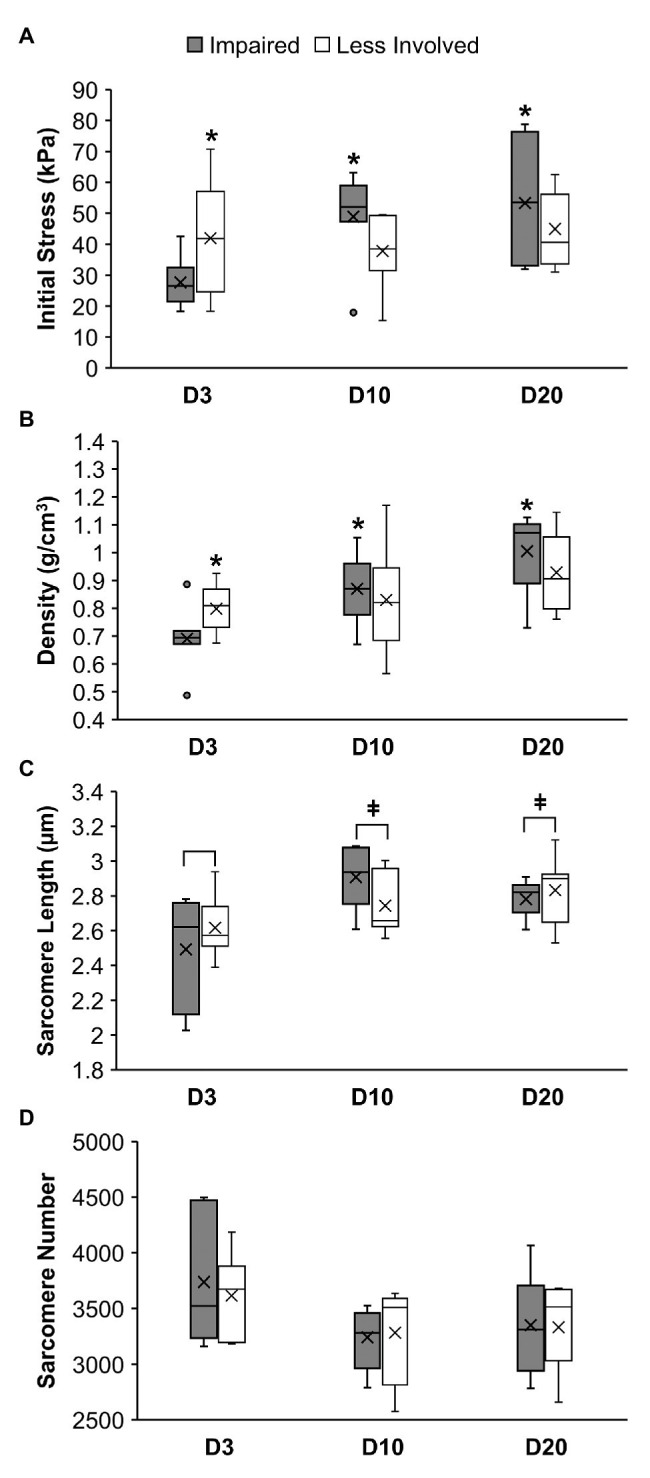
Muscle stress (A), muscle density (B), sarcomere length (C), and sarcomere number (D) of the soleus muscle in mice at 3 days (D3), 10 days (D10), or 20 days (D20) following ischemic stroke. *Denotes a significant difference (p < 0.05) when compared to the impaired limb of the D3 group. ǂDenotes a significant difference (p < 0.05) when compared to the D3 group (i.e., both limbs combined).